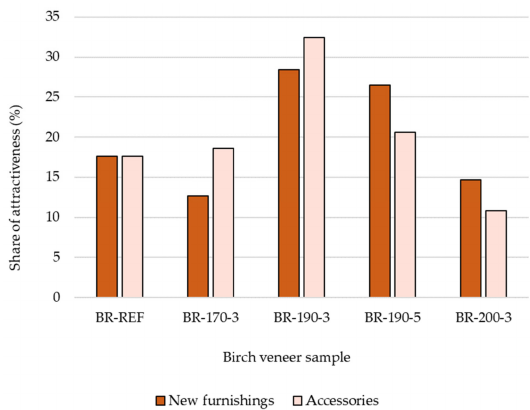
Figure 14. The preference in the samples in the case of purchasing accessories and new flat furnishings—birch veneer. BR-REF = untreated birch veneer; BR-170-3 = birch veneer treated at 170 ◦ C / 3 h; BR-190-3 = birch veneer treated at 190 ◦ C / 3 h; BR-190-5 = birch veneer treated at 190 ◦ C / 5 h; BR-200-3 = birch veneer treated at 200 ◦ C / 3 h.